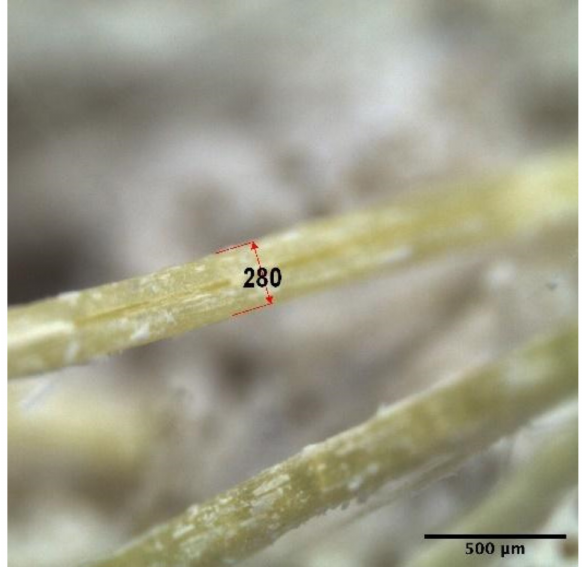
Figure 2. A 40 × magnification of Sisal wire with Leica stereo microscope. Scale in micrometer (1 µ m = 0.001